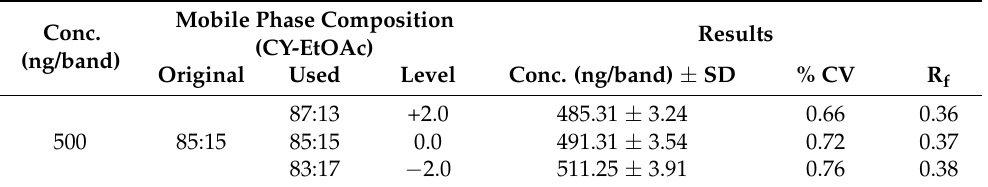
Table 4. Results of robustness assessment of thymol for the proposed analytical approach a .